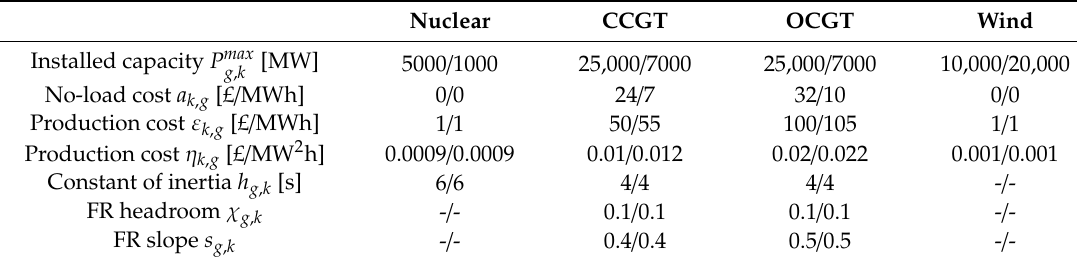
Table 2. Generation